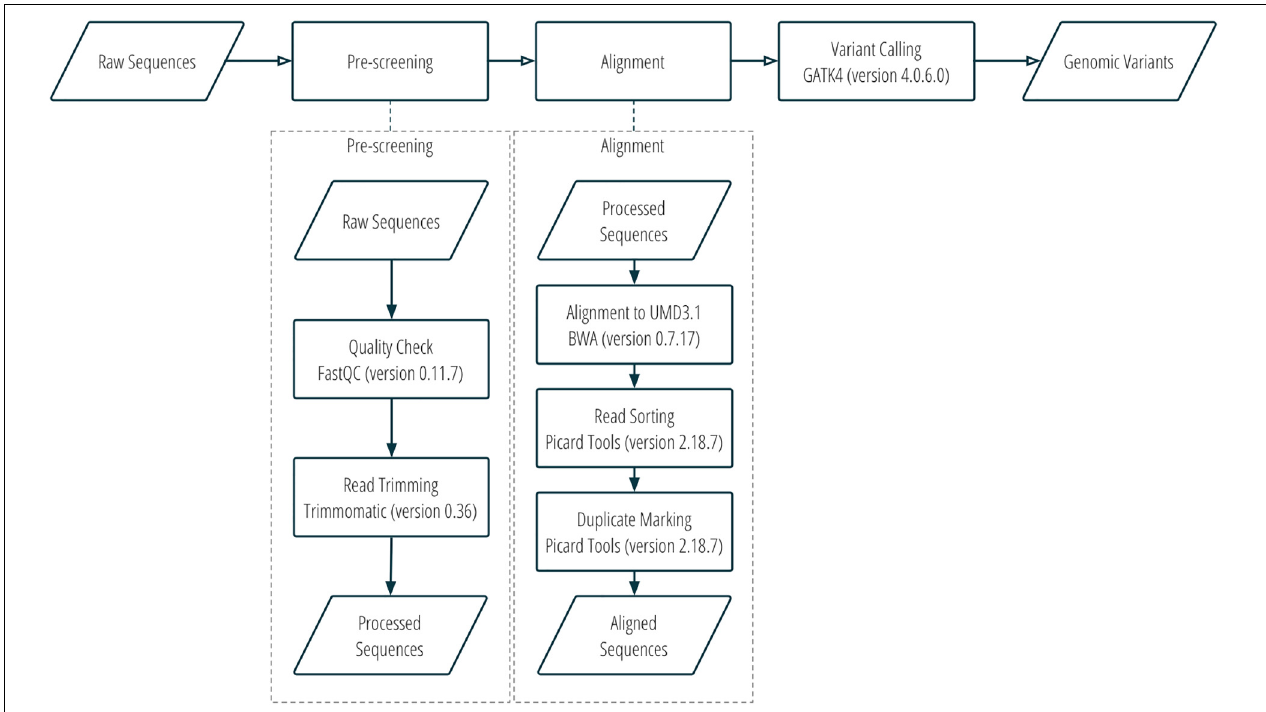
FIGURE 1 | Sequence alignment and SNP calling